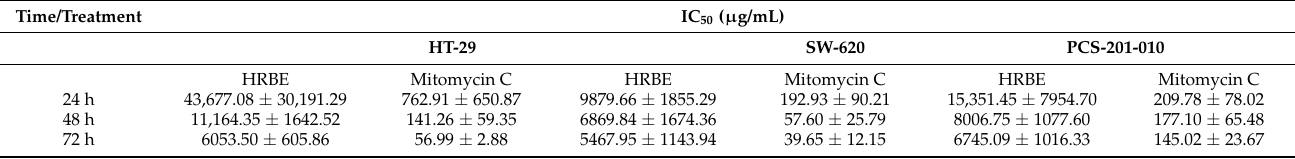
Table 1. IC 50 values of HRBE and mitomycin C on three different cell lines.